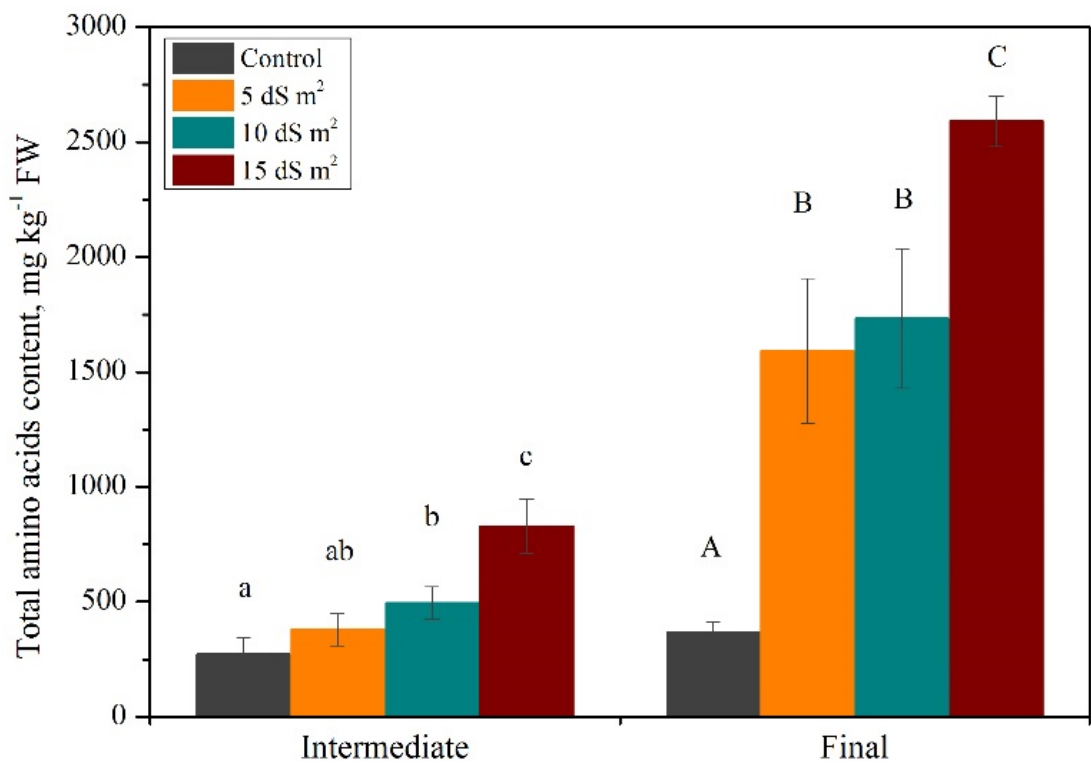
Figure 3. Total amino acid content of basil leaves grown under the various salinity treatments at the intermediate and final harvests. Values in all layers are expressed as mean ± standard deviation ( n = 5). Different letters indicate statistically significant differences between treatments at each harvest (small letters refer to the intermediate and capital ones to the final harvest, p < 0.05).